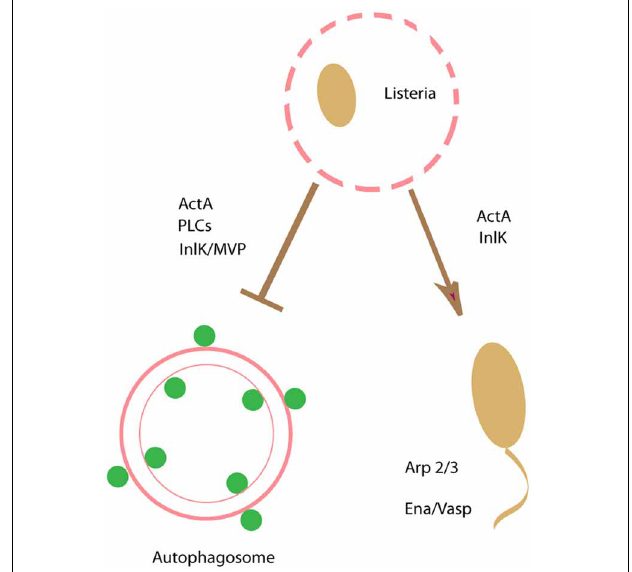
FIGURE 3 | Escaping from autophagy recognition. Listeria monocytogenes uses an actin-based motility to escape from autophagy.ActAand PLCs are key bacterial factors to prevent bacteria targeting by autophagy. Recruitment to the bacterial surface of the actin nucleating proteins Arp2/3 and Ena/VASP, mediated by ActA, camouflages the bacteria from autophagic recognition. In addition, a member of the internalin family of proteins, InlK, a protein expressed at the surface of Listeria , and its host partner the Major Vault Protein (MVP) prevents L. monocytogenes from autophagic